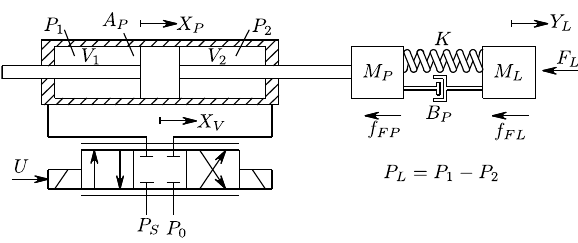
Figure 3: Schematic diagram of the electro-hydraulic plant considered. A servo valve controls the position of the hydraulic cylinder. The load is represented by a variable mass- spring-damper combination. The system shown in